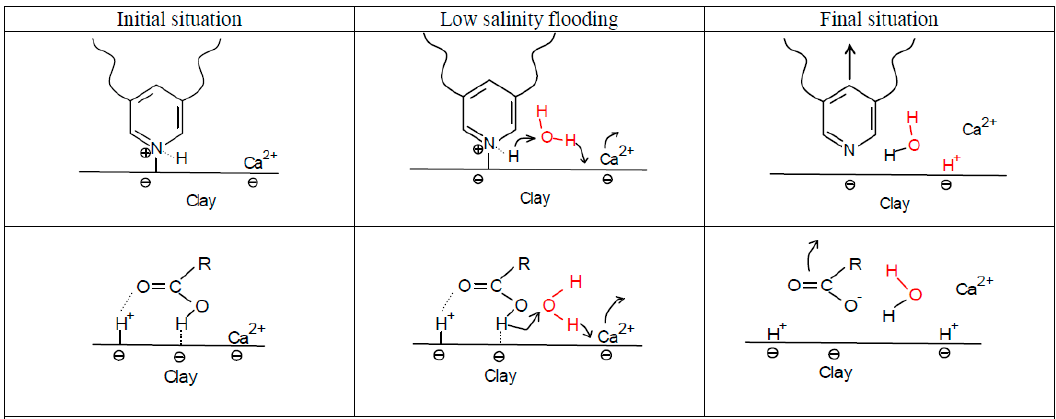
Figure 9. An illustration of proposed mechanism of wettability alteration by “pH gradient” for basic ( upper ) and acidic ( lower ) oil components desorbed from clay mineral surfaces through acid/base- proton transfer, yielding a pH increase (reproduced from Austad et al.